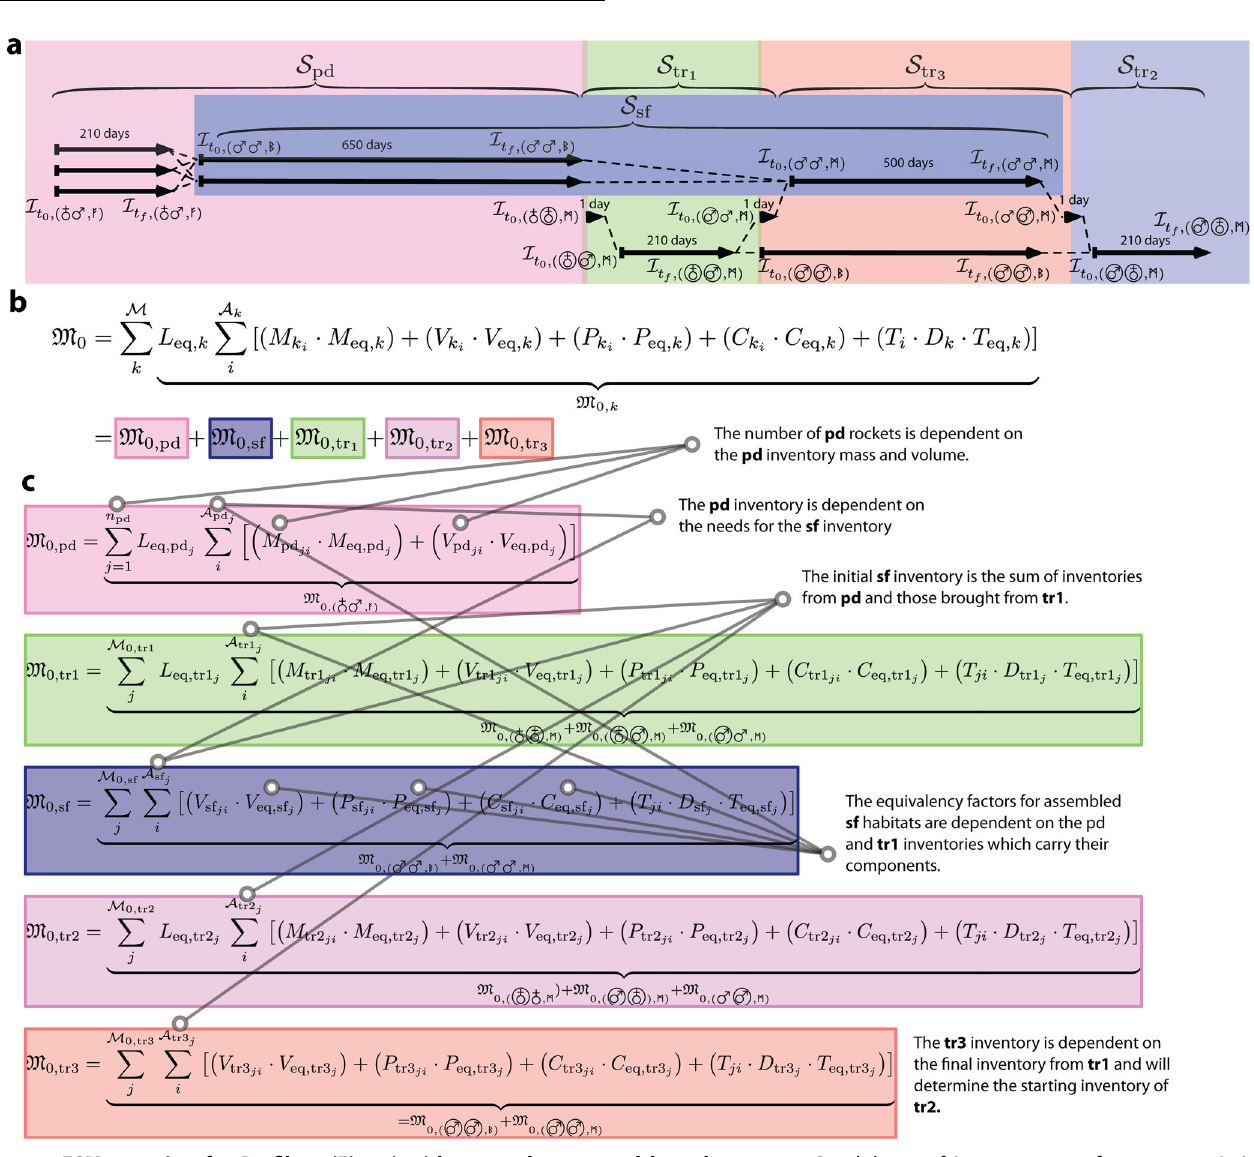
Fig. 2 xESM equation for Pro fi le 3 (Fig. 1) with terms decomposed by subsystem. a Breakdown of inventory transfers across mission timeline colored by mission segment. b The generalized xESM equation colored by mission segment. c Expanded xESM equation with colored by mission segment with a non-exhaustive set of speci fi c segment-dependent relationships elucidated. Legend: Predeployment (pd): pink. Legend: Transit 1 (tr 1 ): yellow. Transit 2 (tr 2 ): blue. Transit 3 (tr 3 ): orange. Surface operation (sf):